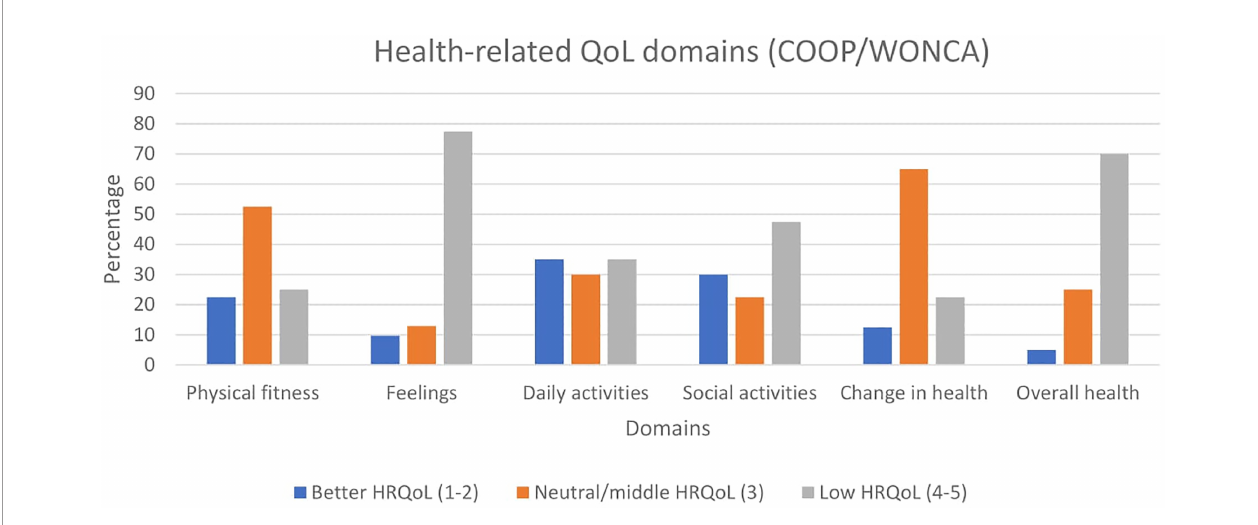
FIGURE 2 | Distribution of HRQOL at baseline (Coop/Wonca). The Five response choices of the Coop/Wonca charts were strati fi ed into three categories: score 1-2 corresponding to better HRQoL; score 4-5 corresponging to the low